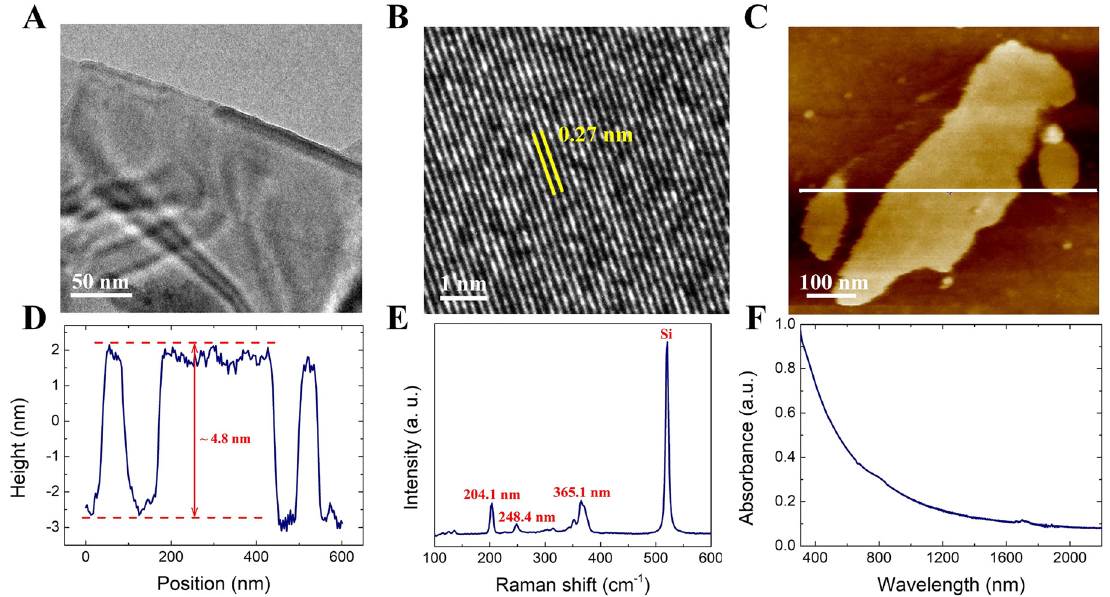
Figure1: Characterizationof2DGePnanoflakes.(A)TEMimage.(B)HR-TEMimage.(C)AFMimage.(D)Heightprofilealongthewhitelinein(C). (E) Raman spectra. (F) Optical absorption spectrum.